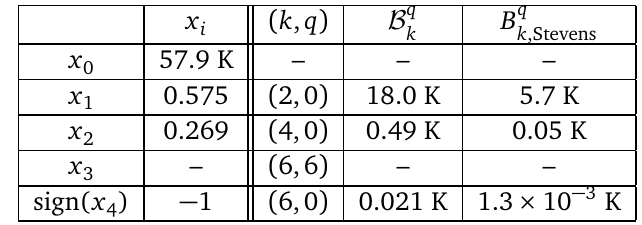
Cu obtained from CNN 2 9